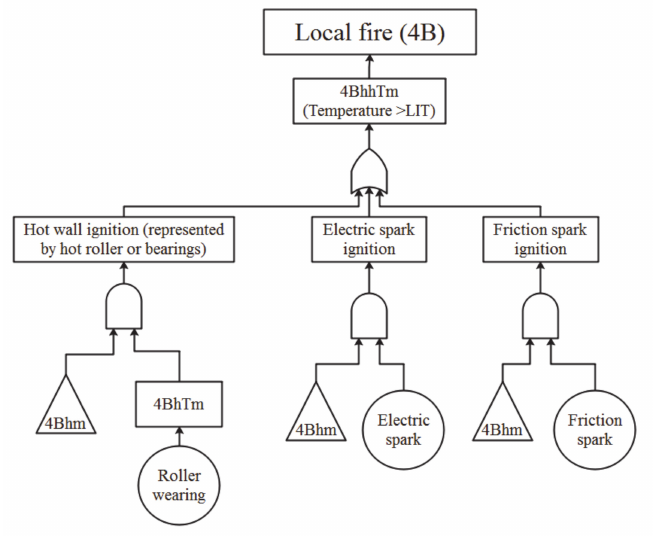
Figure 4. Fault tree for the local fire top event. 4Bhm—high mass inside node 4B; 4BhTm—high temperature of mechanical parts inside node